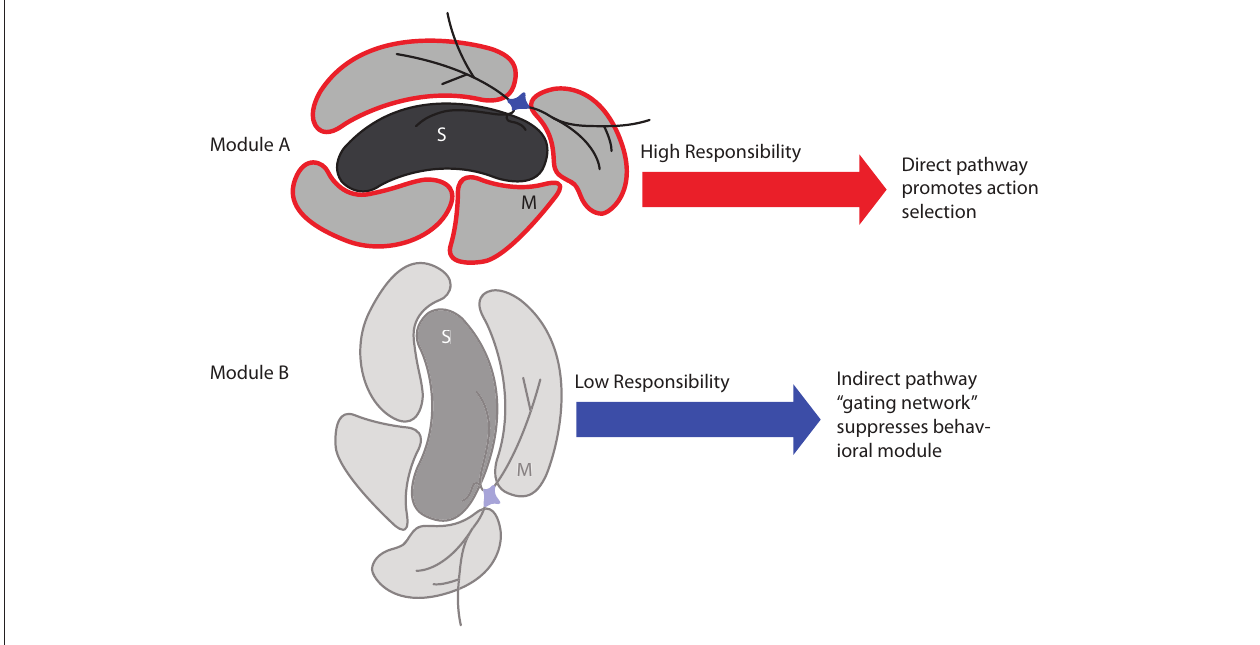
pathway and high activity in the direct pathway, which permits the direct pathway to promote selection of an action. Bottom: If the sets of actions influenced by module B are inappropriate to the environmental context, its striosome assigns low responsibility. This results in relatively high activity in the indirect pathway, which suppresses the associated set of candidate actions